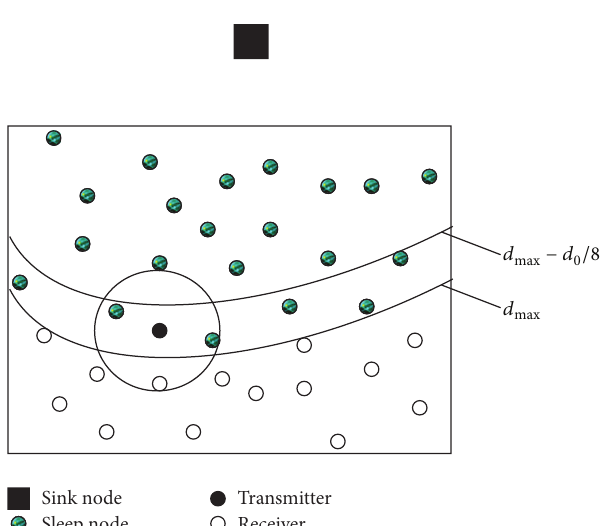
Figure 2: CFWA algorithm time structure diagram.